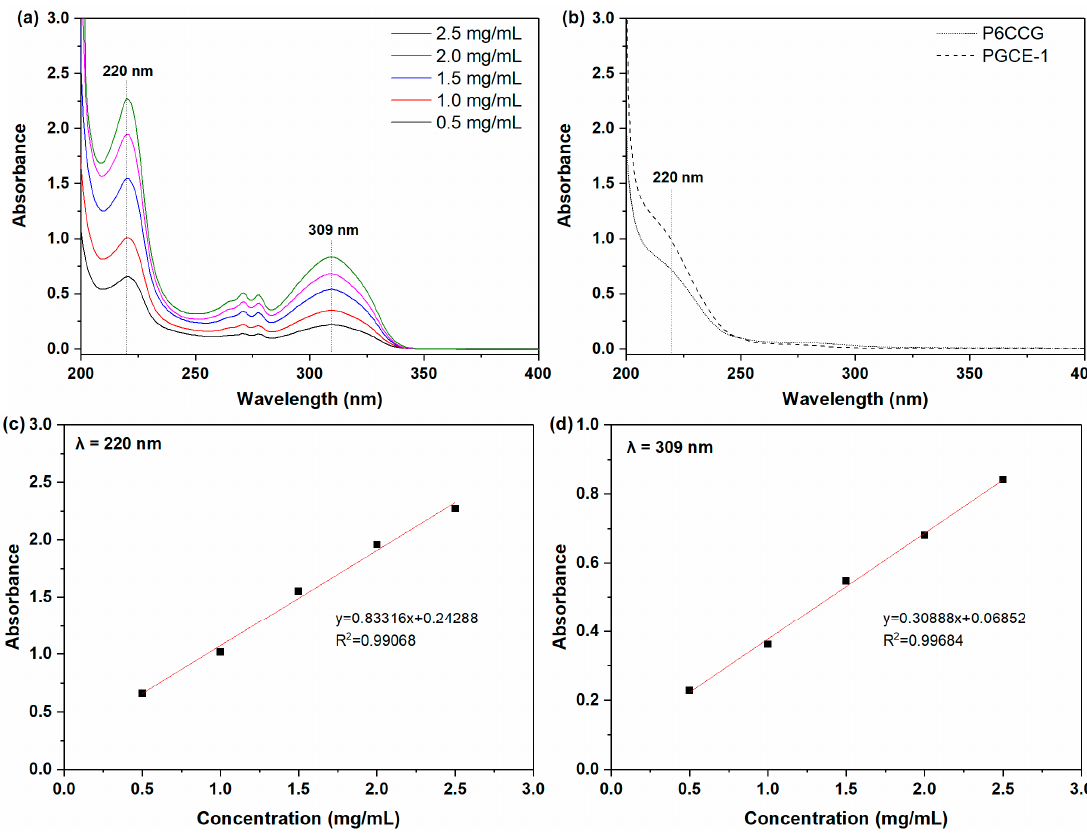
Figure 5. UV spectra of ( a ) pen eyeliner and ( b ) PGCE-1 (1 wt%) and polyethylene glycol (PEG)-6 caprylic/capric glycerides (P6CCG) (1 wt %) in acetonitrile; standard curves for removal efficacy evaluation against pen eyeliner at ( c ) 220 nm and ( d ) 309 nm.